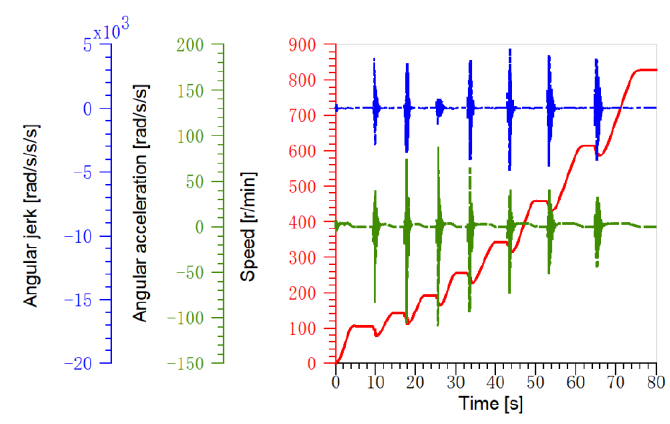
Figure 14. Parameter variation curve of the AMT’s output shaft.